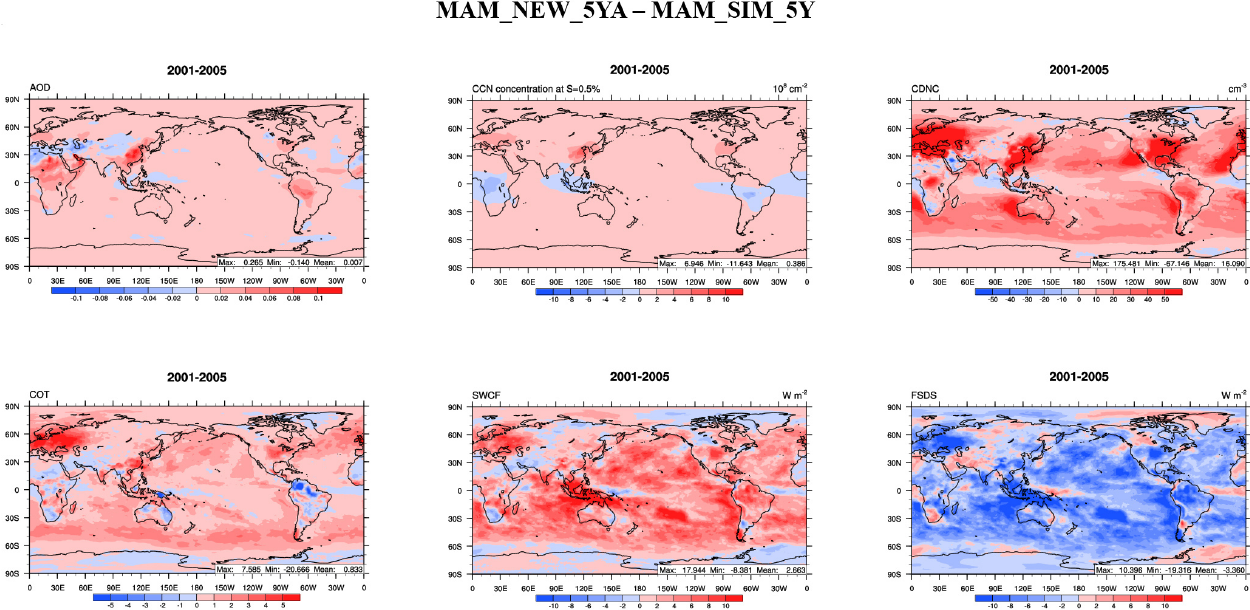
Figure 8. Absolute differences of major cloud and radiative variables between MAM_NEW_5YA and MAM_SIM_5Y for 2001–2005.